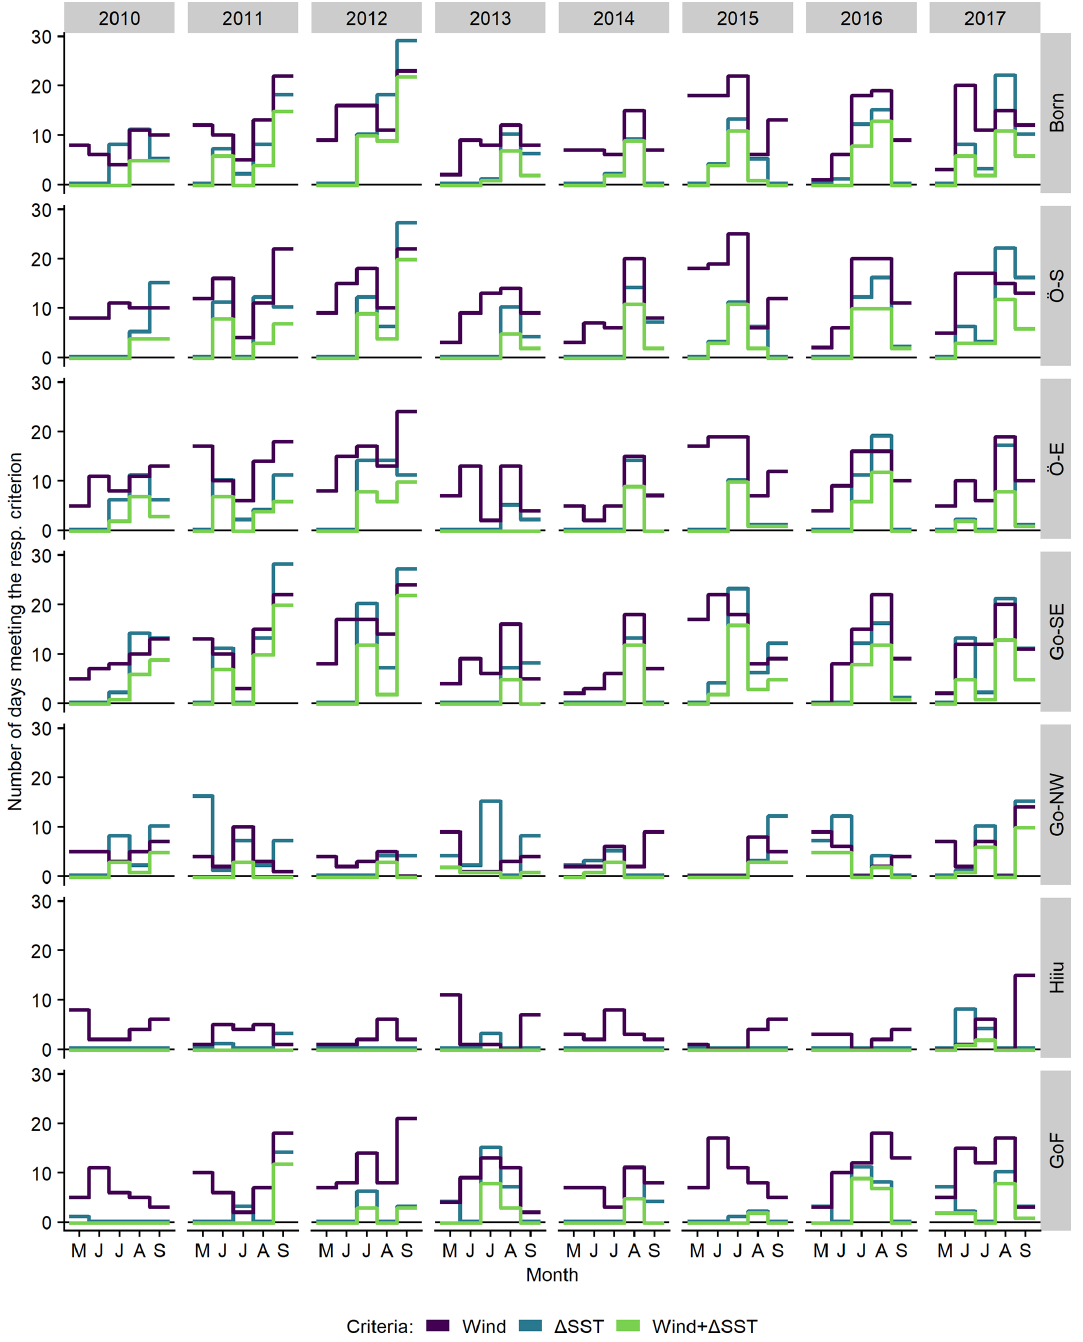
Figure B1. As Fig. 5, but further distinguished by year. (cid:49) SST was calculated along the route of SOOP Finnmaid through the boxes (Sect. 2.3; second approach). Month abbreviations denote the period